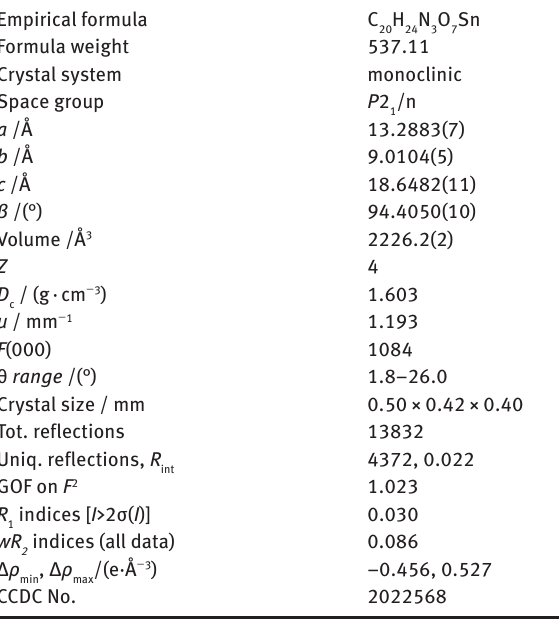
Table 2: Crystallographic and refinement data for 1 .